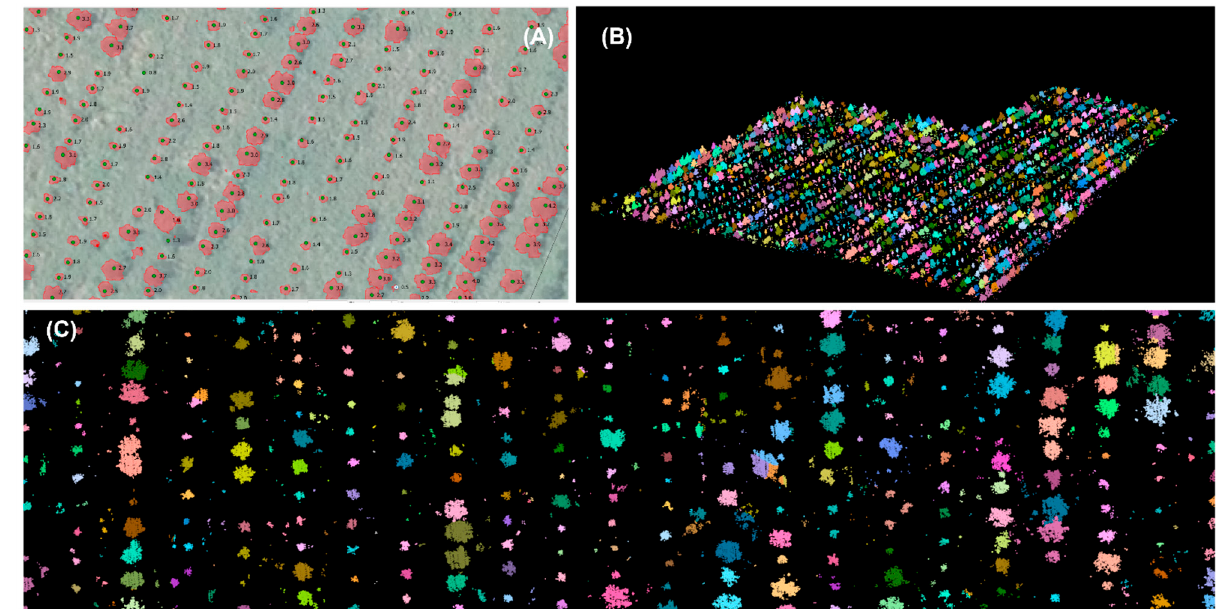
Figure 2. Example of visualization of the A028SAN plot. ( A ) Two-dimensional view on QGIS showing tree crown segmentation, point cloud height and treetops, ( B ) 3D view of the point cloud where each tree is represented with a different color, and ( C ) top view of the 3D cloud from the results of the Li2012 algorithm from the lidR package.